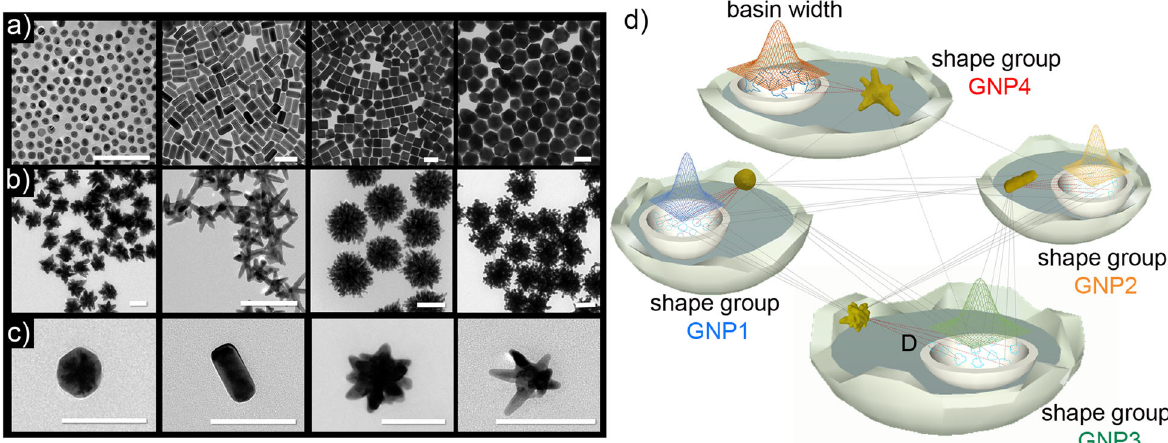
Fig. 1 Nanoparticle shape groups. TEM micrographs illustrating a library of different gold NPs with a regular geometrical shapes and b branched shapes. c Four representative NPs shapes used in this work. From the left: GNP1 ( “ nanospheres ” ), GNP2 ( “ nanorods ” ), GNP3 ( “ nanourchins ” ), and GNP4 ( “ nanostars ” ). Scale bars are 100 nm. d Schematic representation of the hyperspace geometrical identity and de fi nition of shape groups (basins of